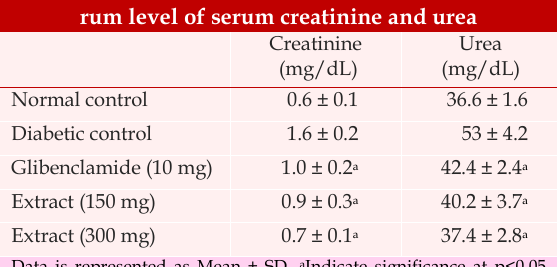
Effect of I. aucheri leaves methanolic extract on se-